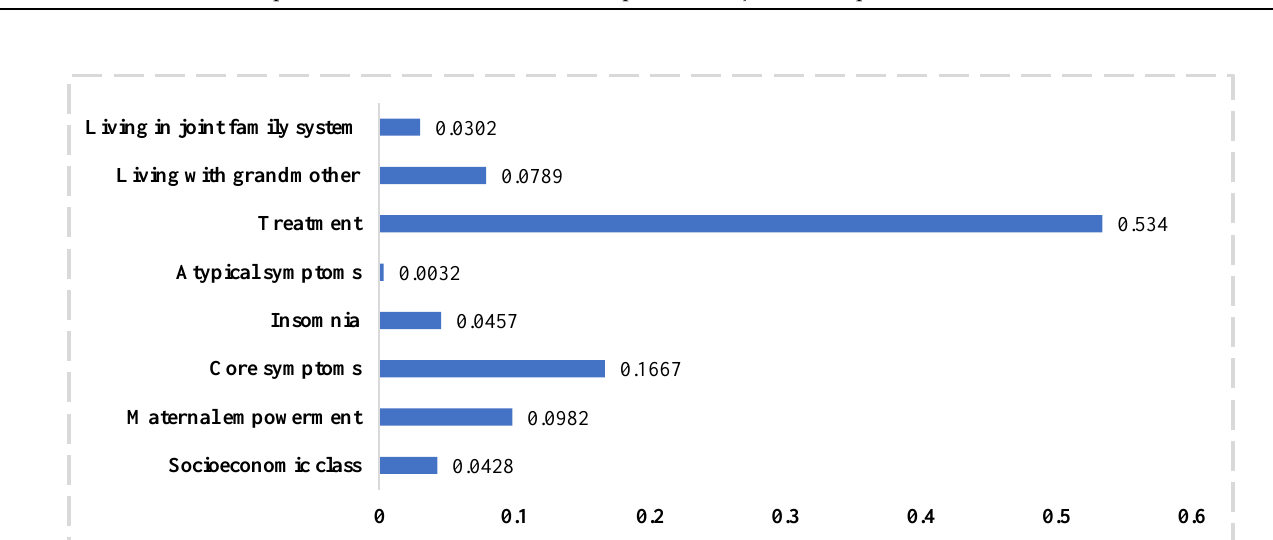
Figure 2. ROC curve presenting discriminatory ability of the prognostic model.